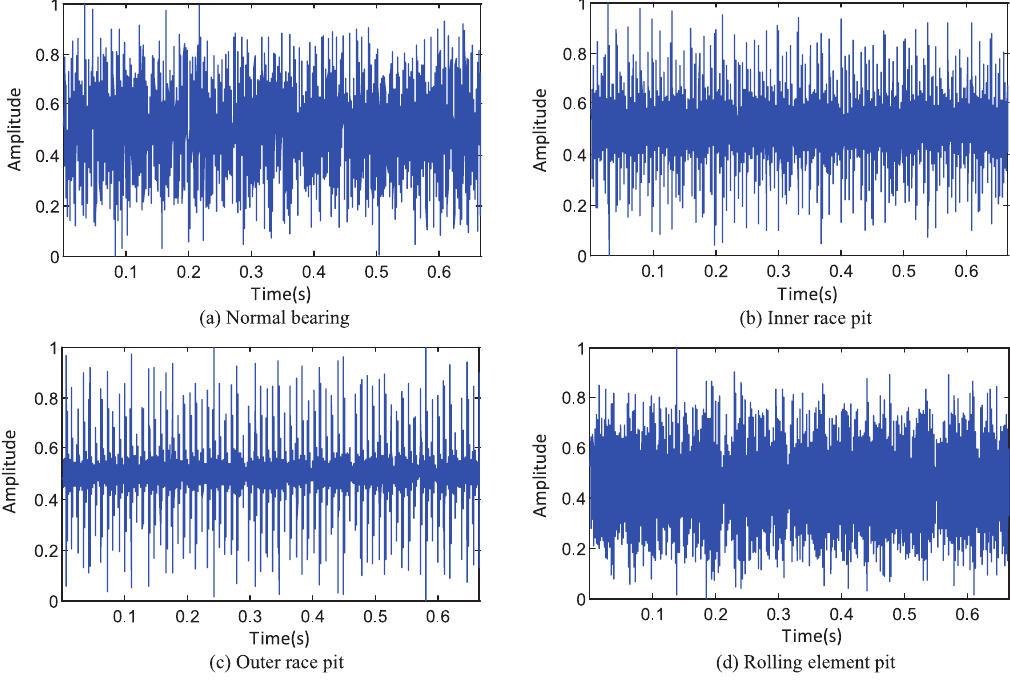
Fig. 4. Waveform of four kinds of bearing fault